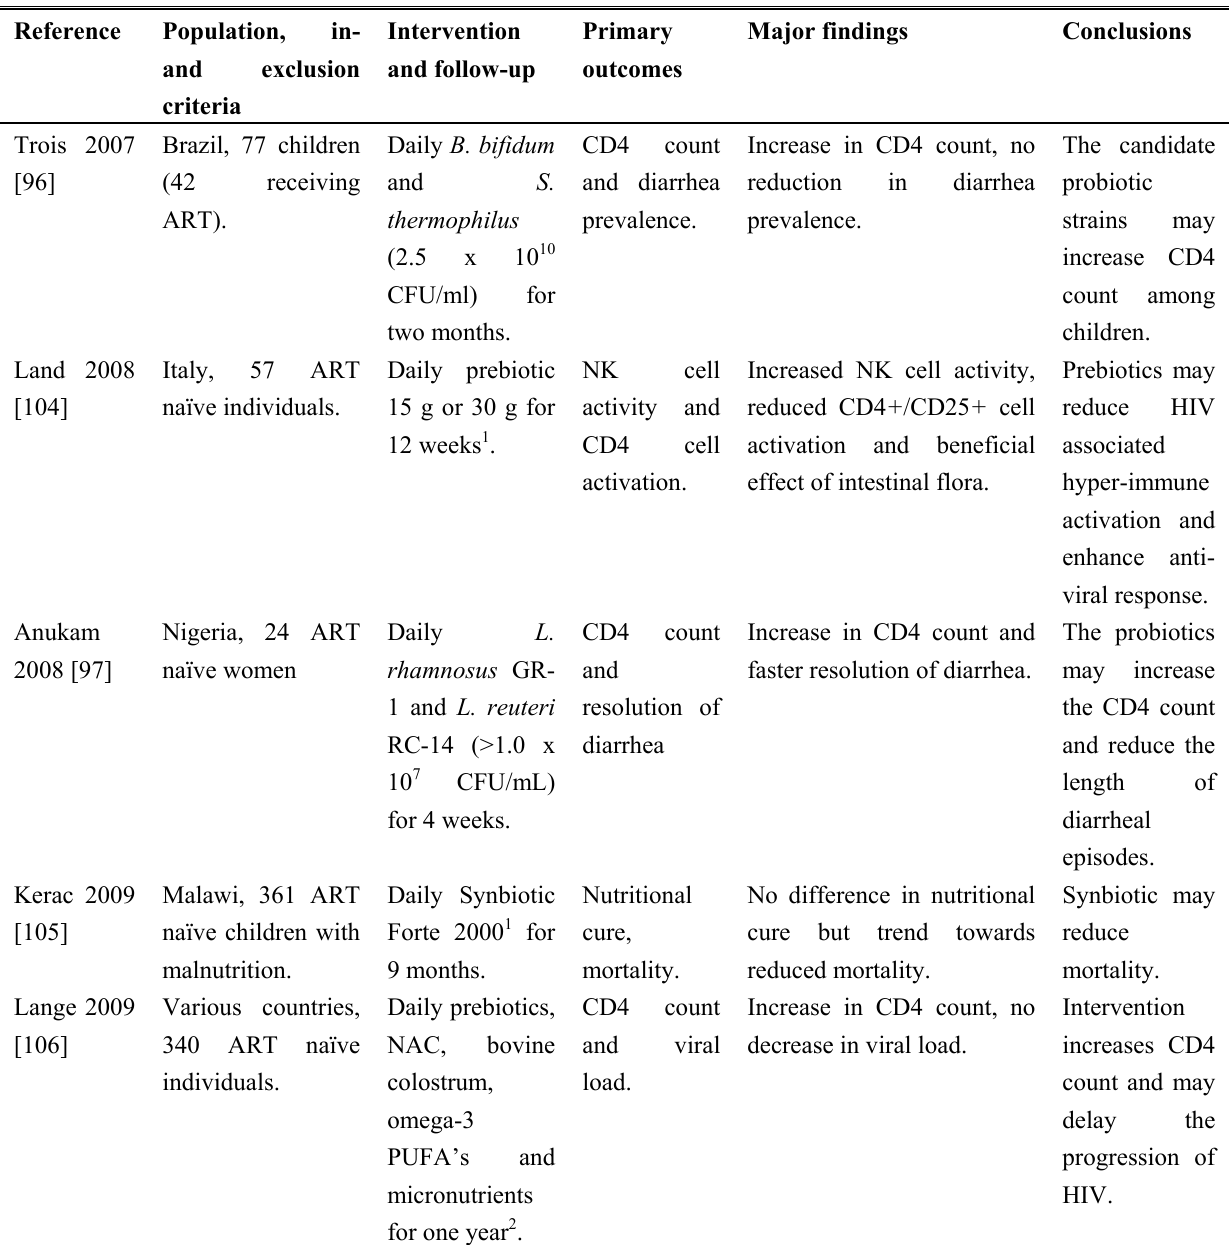
Table 7. Randomized, placebo controlled trials on probiotics and prebiotics and HIV